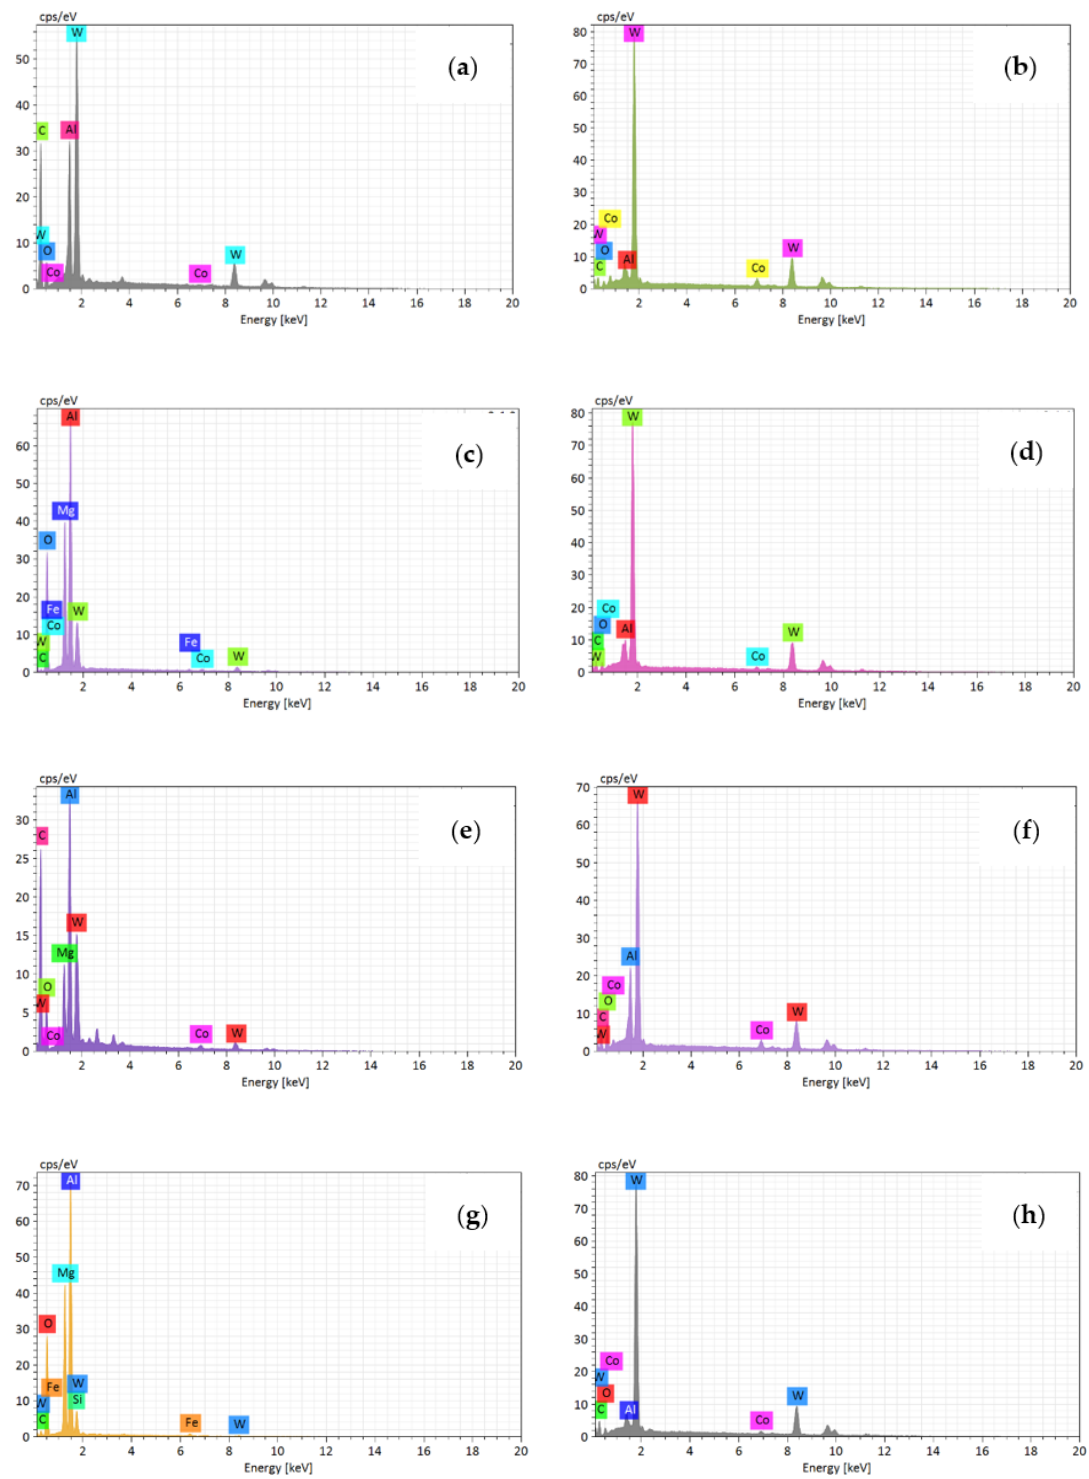
Figure 7. The energy dispersive spectrometer (EDS) results of rake face wear morphology at different feed (( a – h ) represent the points A~H in the Figure 6 respectively).